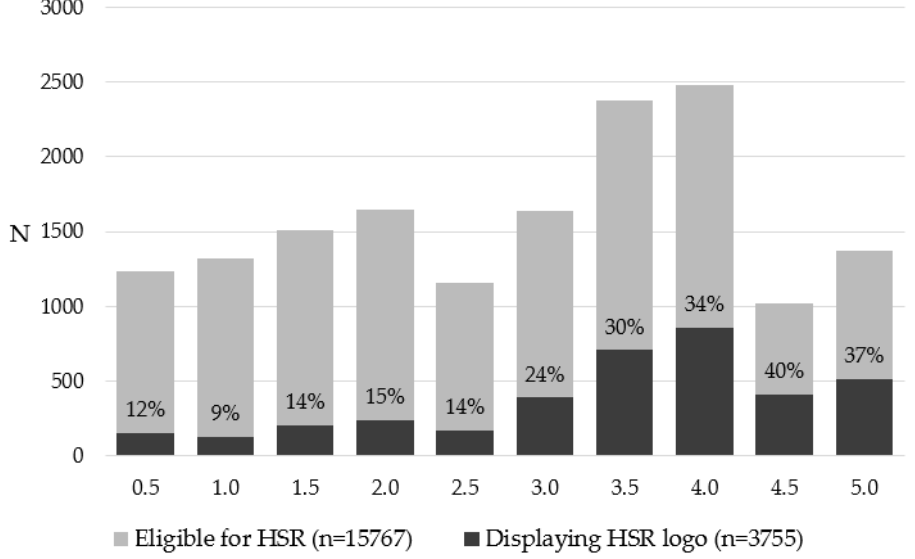
Figure 2. Uptake of the HSR logo by HSR value in the 2017 FoodSwitch Monitoring Database. Percent numbers indicate proportion of eligible products with each HSR value that carry a HSR logo on pack.